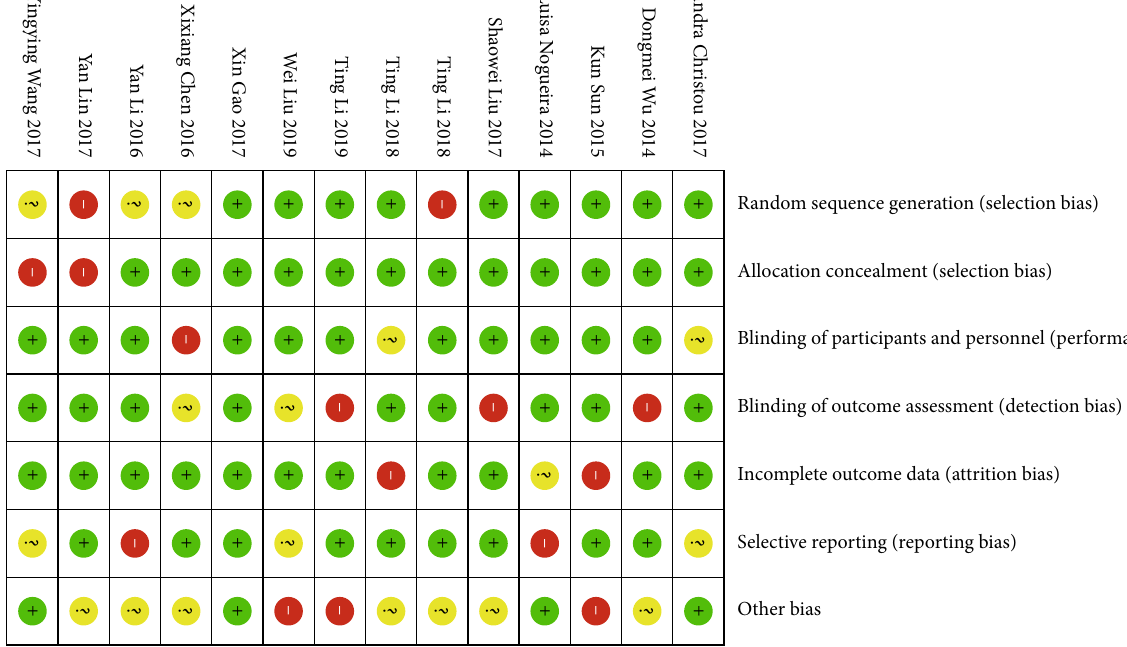
Figure 2: Quality assessment of the included studies using the QUADAS-2 tool. Table 2: Assessment of the diagnostic accuracy and heterogeneity in subgroup